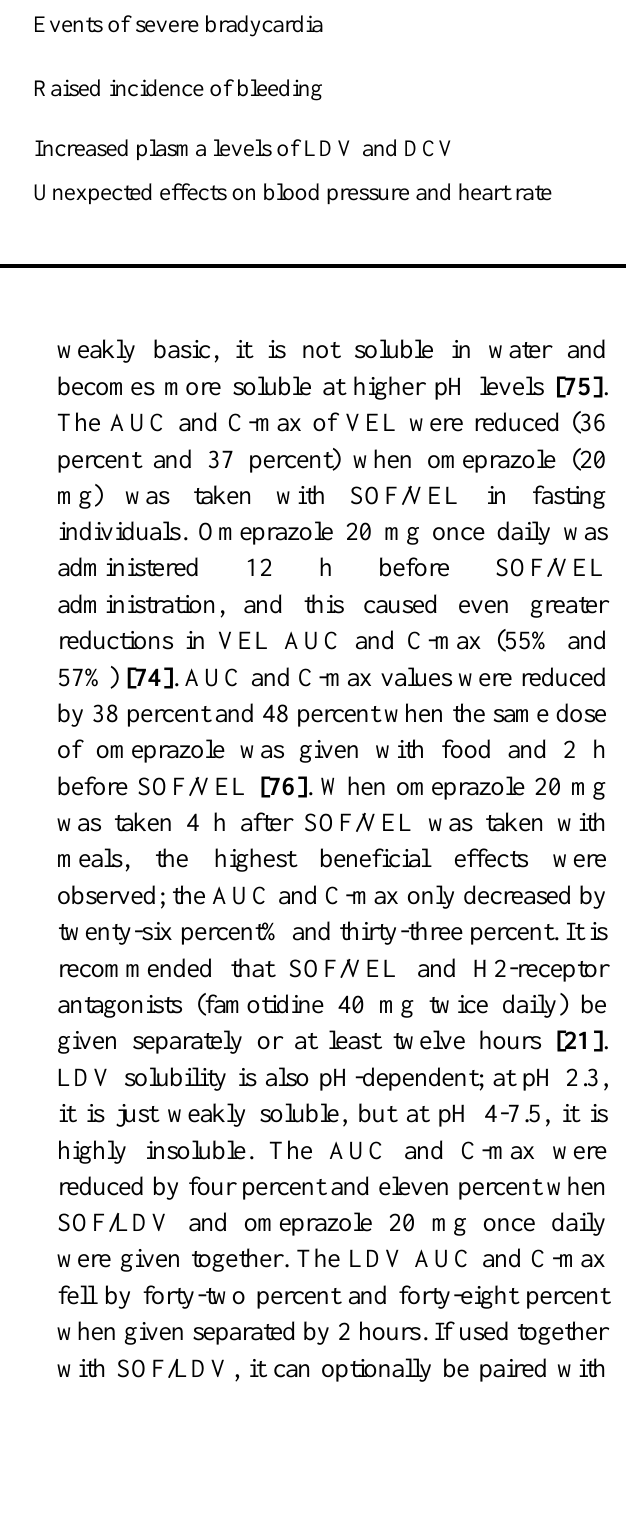
Table 5. Drug-Drug interactions between DAAs and CVS Drugs DAAs CVS Drugs Drug-Drug Interaction All DAAs Statins